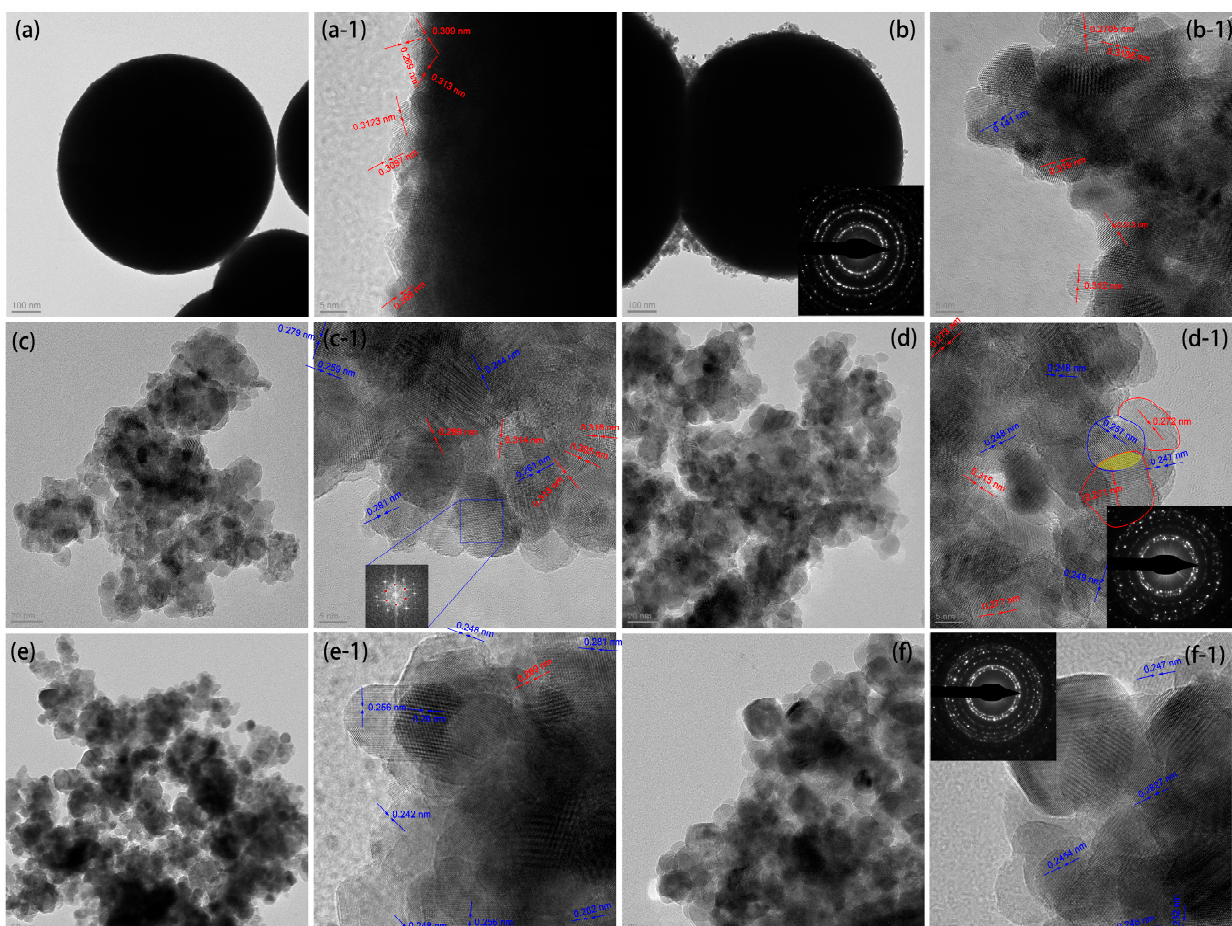
Figure 3. TEM images of ( a ) CeO 2 , ( b ) CeO 2 @ZnO-0.2, ( c ) CeO 2 @ZnO-0.45, ( d ) CeO 2 @ZnO-0.67, ( e ) CeO 2 @ZnO-0.8, and ( f ) ZnO. The suffix “-1” indicates the high-resolution TEM images, and the insets show the corresponding selected area electron diffraction patterns. The lattice fringes in red and blue correspond to CeO 2 and ZnO,